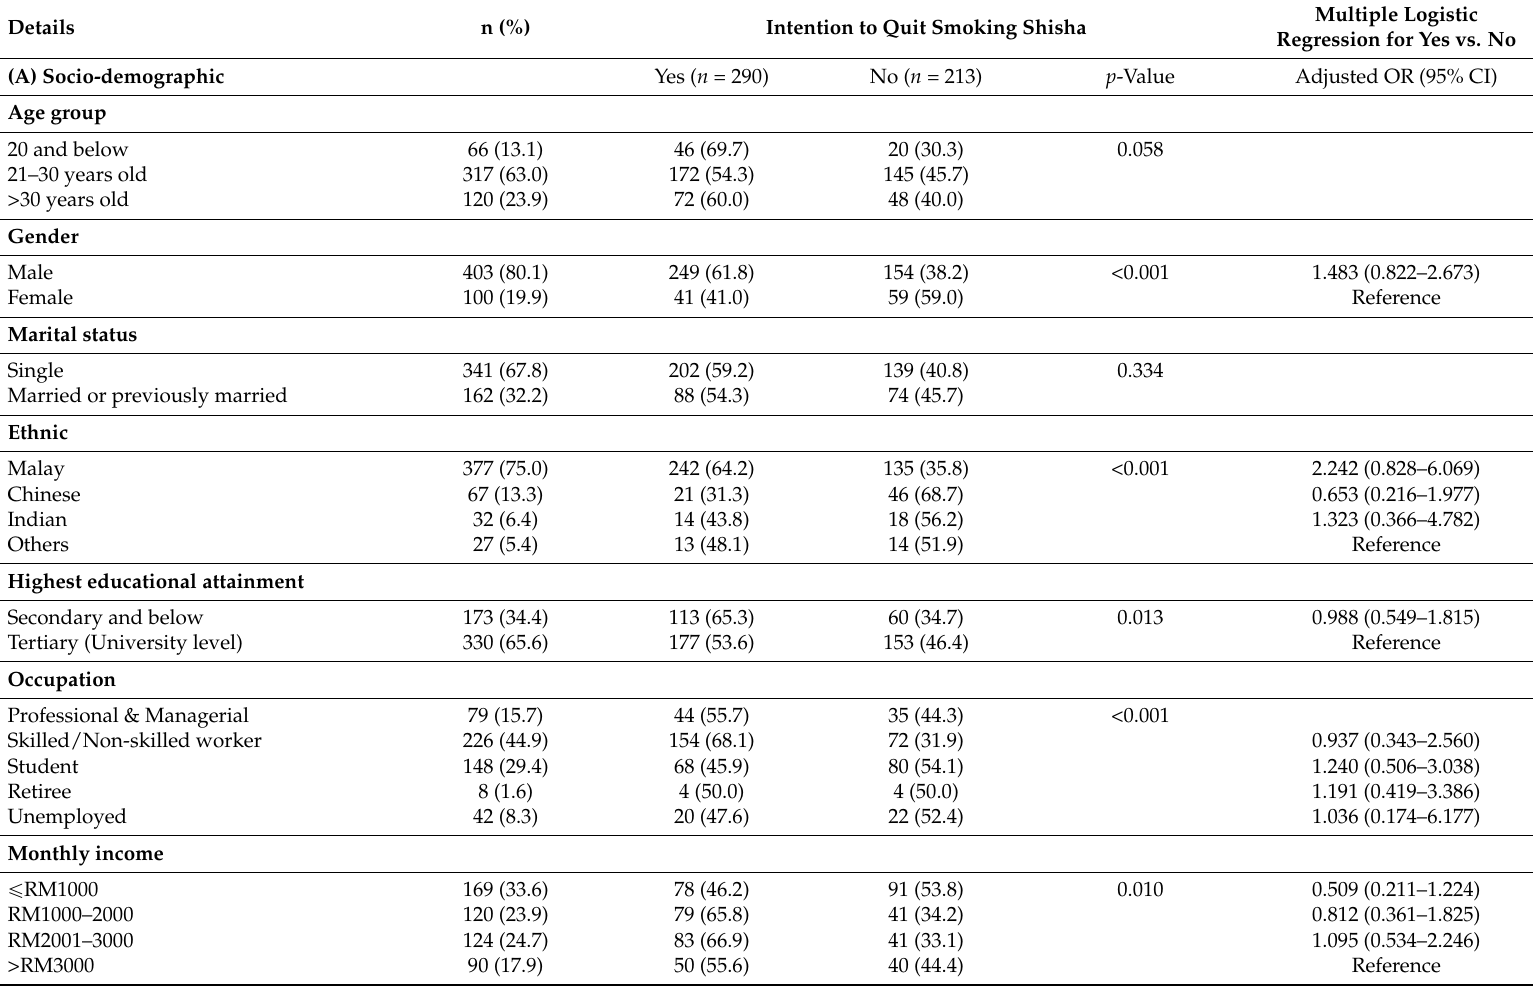
Table 3. Association between socio-demographic characteristics, shisha smoking practices, reasons for using shisha, total adverse health effects and intention to quit smoking shisha ( N =